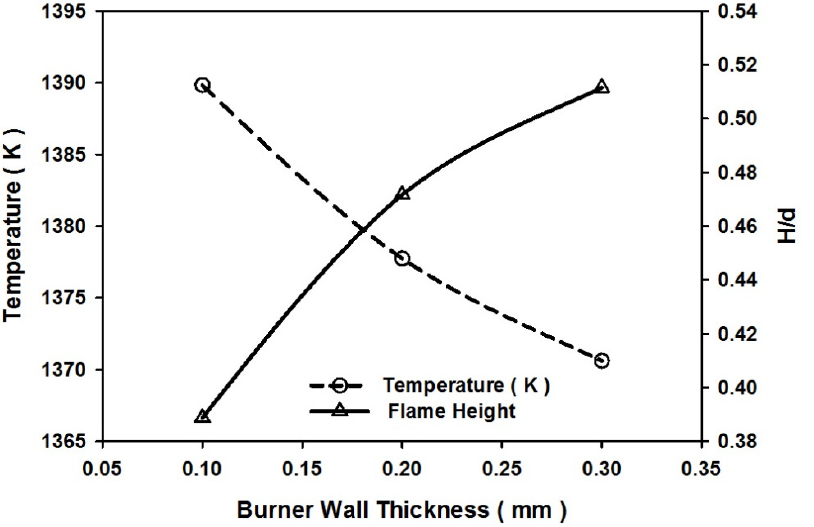
Figure 12. Comparison of flame heights and maximum flame temperature with burner tube thickness. The burner wall material is quartz, and the fuel jet velocity = 0.14 m/s. Radiation effects are included.